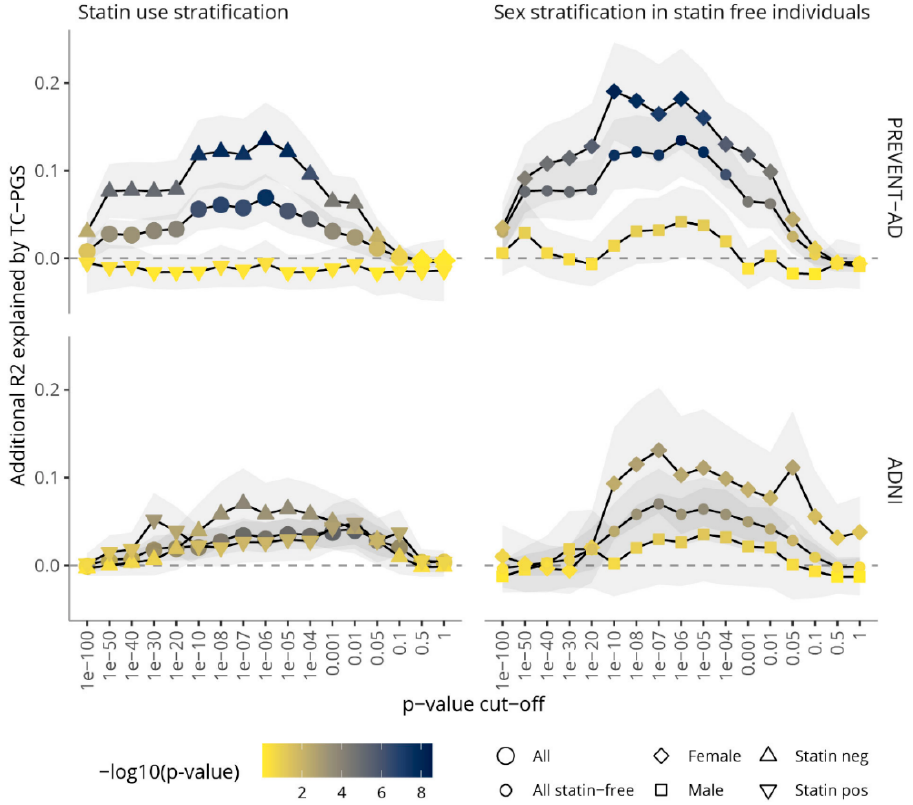
Figure 1. Variance explained by TC-PGS on TC levels over multiple p -value cut-offs. Multiple p -value thresholds were evaluated for association with TC levels in PREVENT-AD (upper panel) and ADNI (lower panel) stratified for statin use (left-hand panel) and sex (right-hand panel) using linear regression corrected for PCs 1–10, APOE - ε 4 status, age, and age 2 . Statin use and sex were included when not stratified for. Plotted is additional variance explained (regression R 2 ) after adding the TC-PGS to the model. Abbreviations: TC-PGS, total cholesterol polygenic score; TC, total